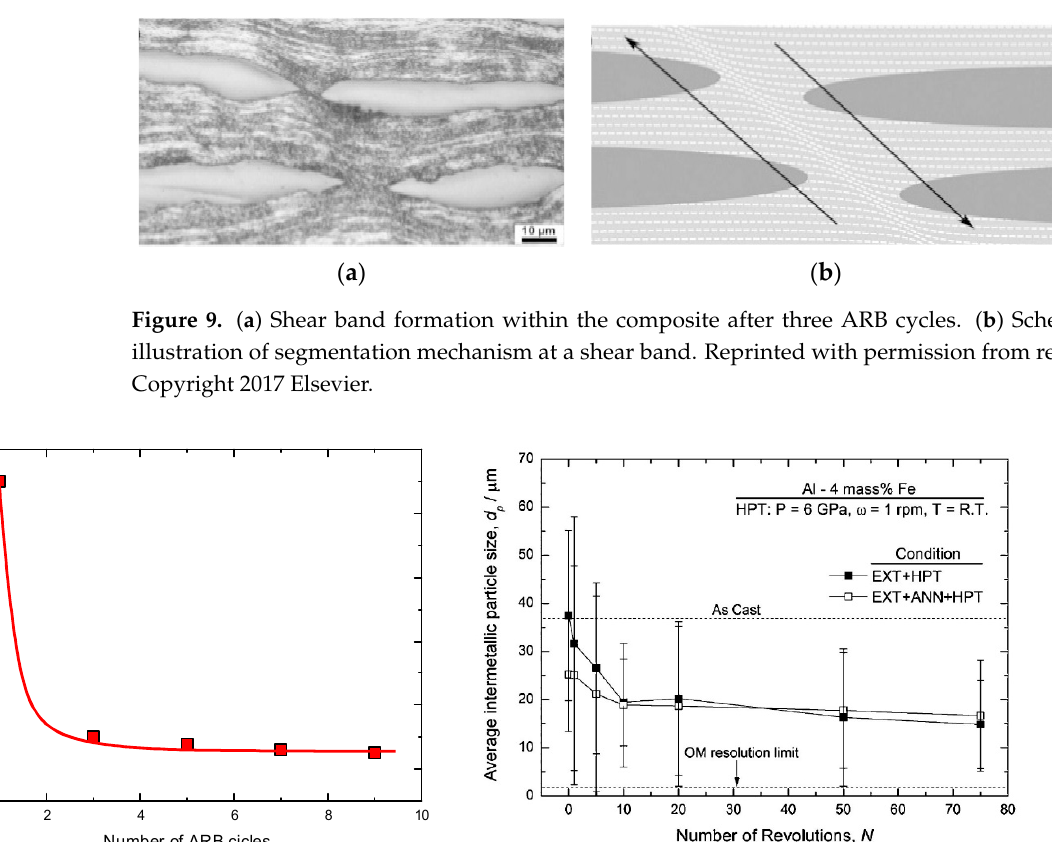
Figure 9. ( a ) Shear band formation within the composite after three ARB cycles. ( b ) Schematic il- lustration of segmentation mechanism at a shear band. Reprinted with permission from ref. [86]. Copyright 2017 Elsevier.